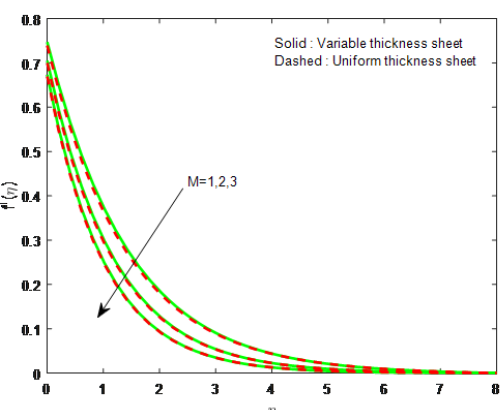
Fig. 2: Influence of M on velocity field